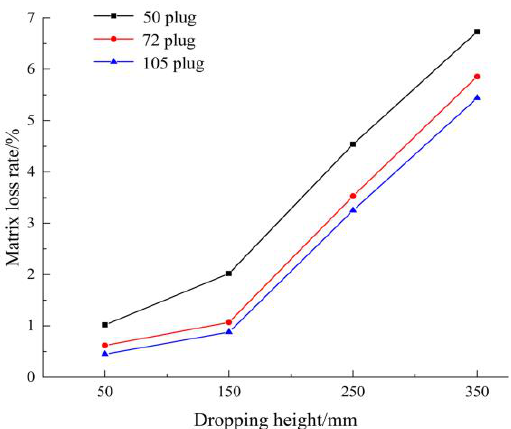
Figure 7. The relationship between matrix loss and drop height of oil sunflower seedlings under different plug specifications.